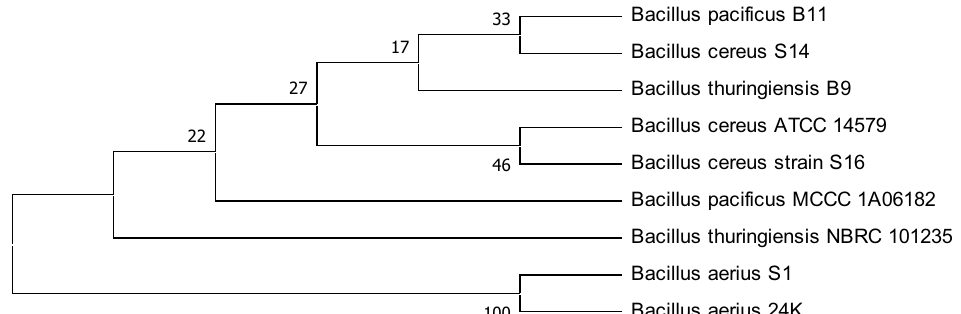
Figure 1: Phylogenetic tree of identi fi ed bacteria.